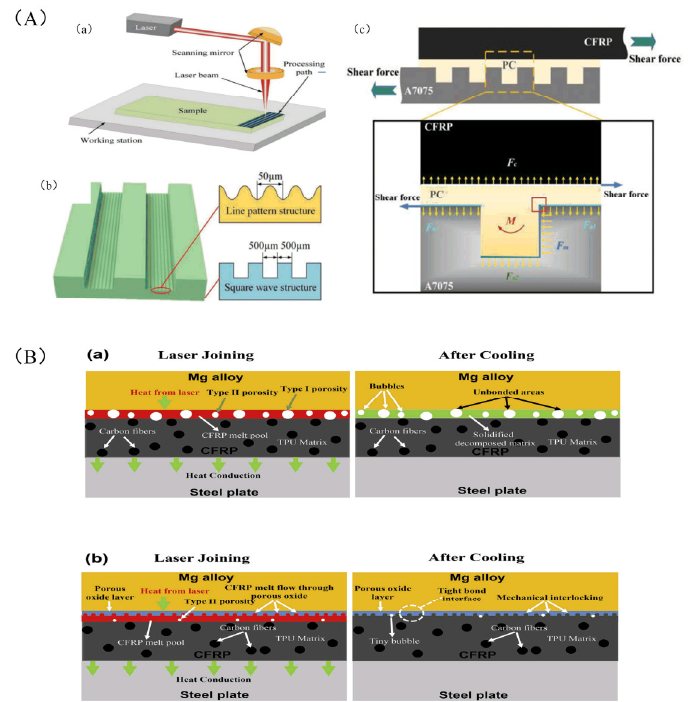
Figure 19. Two different principles of laser cleaning of CFRP: ( A ) A7075 sheet laser surface treatment; ( a ) schematic diagram of laser surface treatment of A7075 plate; ( b ) schematic diagram of two different microscopic structures; ( c ) force analysis diagram [126]; ( B ) schematic diagrams illustrating the mechanisms involved in the LAMP joining between the CFRP and AZ31 Mg alloy; ( a ) CFRP and as-received AZ31 Mg alloy; ( b ) CFRP and thermally oxidized AZ31 Mg alloy [130].